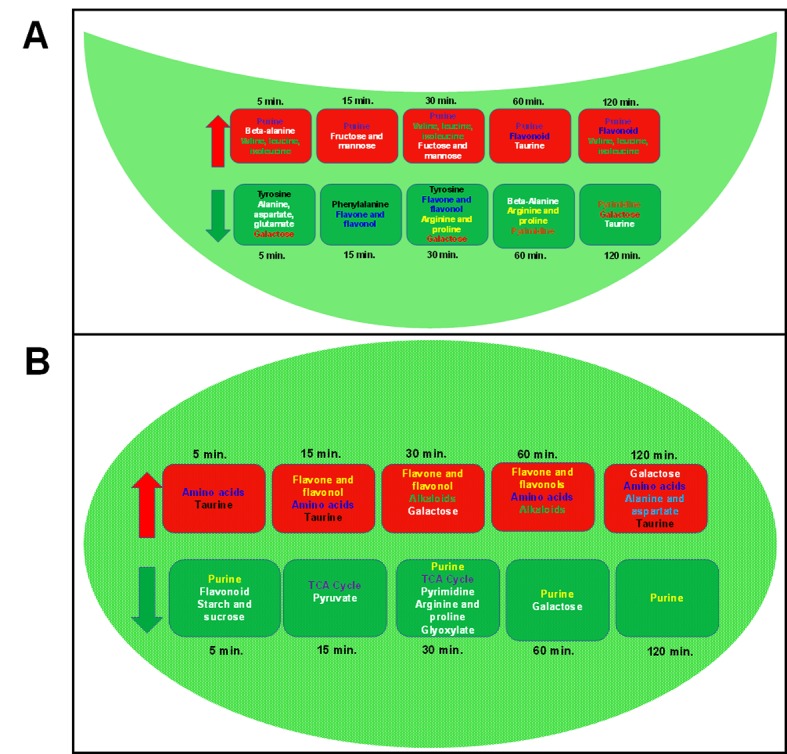
Summary of the increased and decreased metabolic pathways in (A) GCs and (B) MCs after HCO3
- treatment.